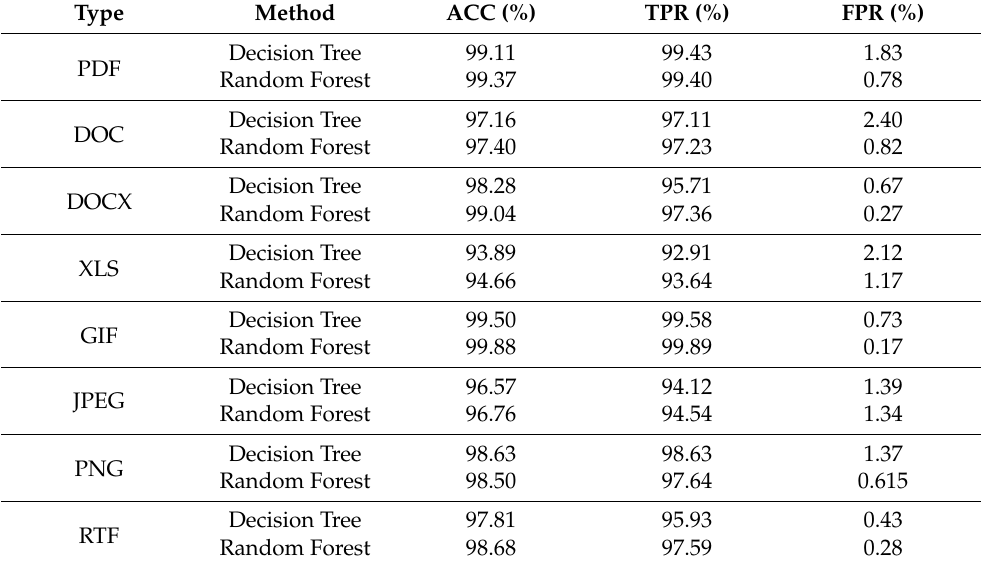
Table 7. The experimental results of various documents under the proposed static detection frame- work for malicious documents based on feature generalization.